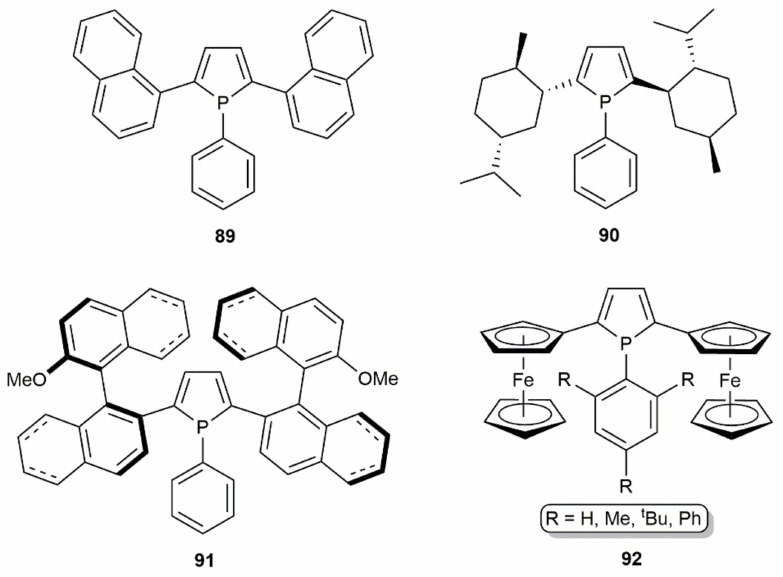
Figure 12. Structure of the 2,5-disubstituted phospholes 89–92 . Base-catalyzed additions of secondary phosphines to 1,3-diynes can also be found in the literature. For example, Schmidbauer and colleagues reported in 1995 the high-yield preparation of 1,1,4,4-tetrakis(diphenylphosphino)-1,3-butadiene 94 by double hydrophos- phination of 1,4-bis(diphenylphosphino)-1,3-butadiyne 93 with Ph 2 PH, using KO t Bu as a promoter (Scheme 50)